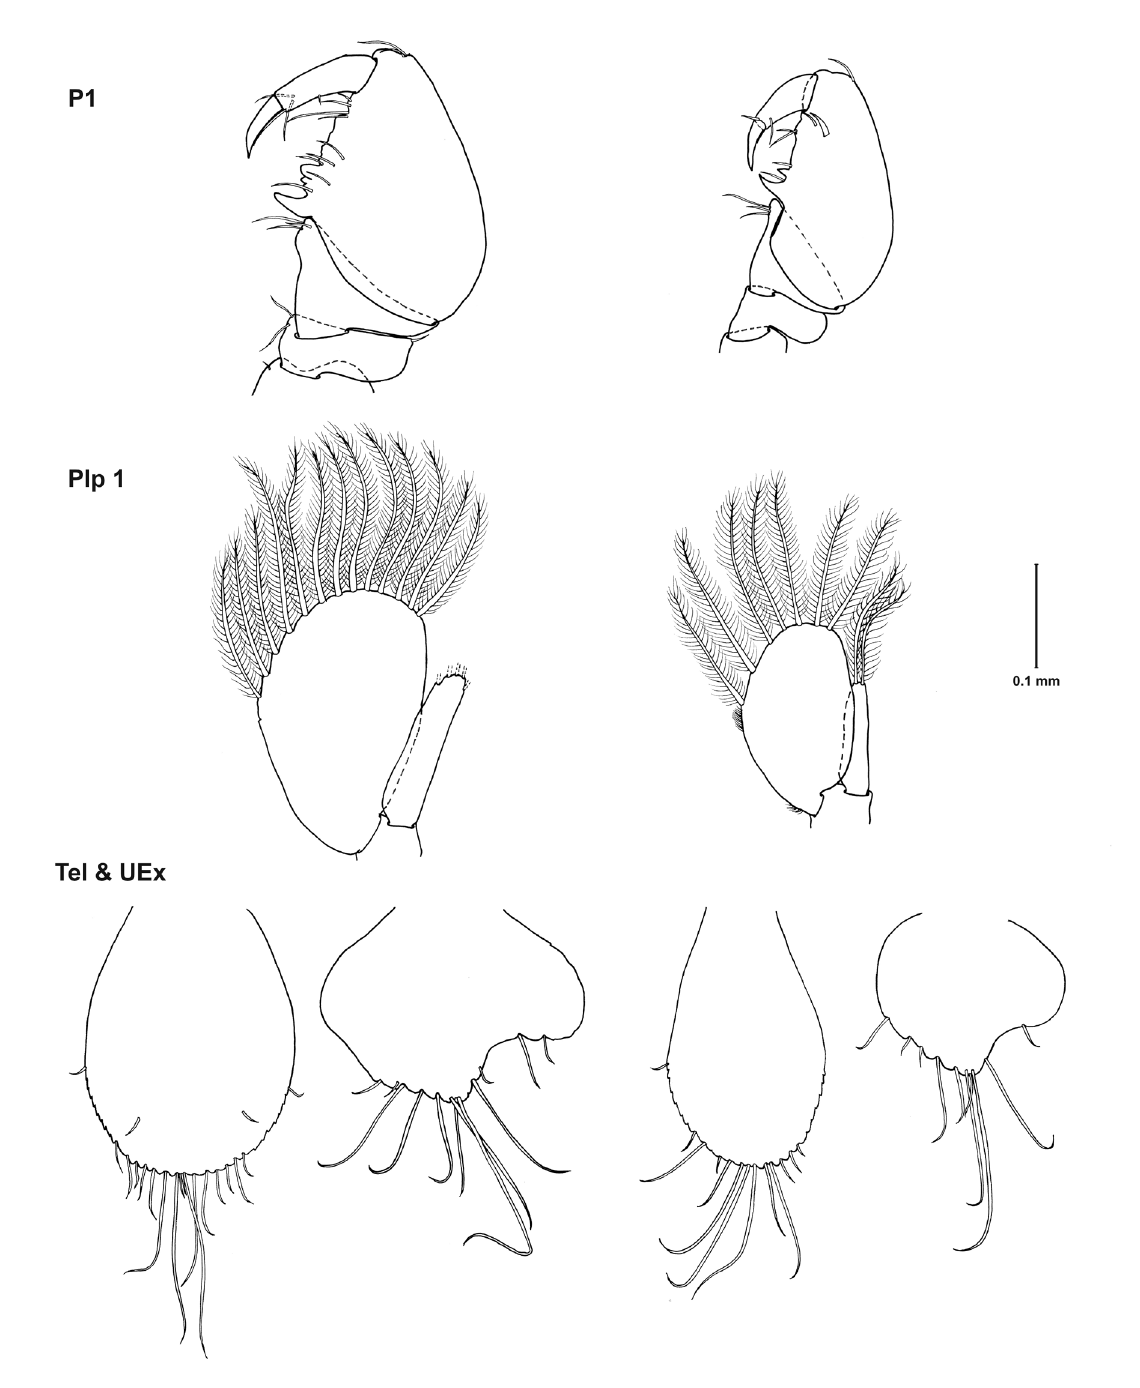
Fig. 21. Expanathura collaris (Kensley, 1979), immature specimens from Bangka Island showing variations (MZB Iso 107). Left: specimen of 2.5 mm; right: specimen of 2.2 mm. Abbreviations: P1 = pereopod 1; Plp1 = pleopod 1; UEx = exopod of uropod; Tel =